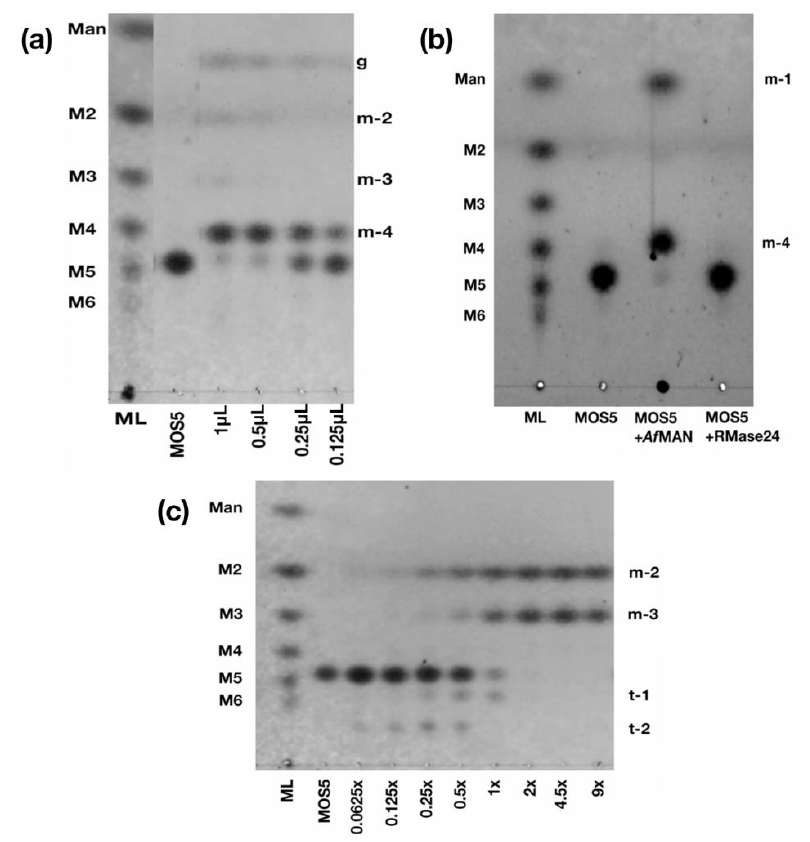
Figure 2. Enzymatic mapping of MOS5. ( a ) Digestion of MOS5 with C Af GLA. 1–0.125 µ L indicates Figure 2 . Enzymatic mapping of MOS5 . (a) Digestion of MOS5 with C Af GLA. 1 – 0.125 µL indicates a a reaction between 1 µ L of 1 µ M MOS5 and 1 µ L to 0.125 µ L of 20 mg / mL C Af GLA, respectively. reaction between 1 µL of 1 µM MOS5 and 1 µL to 0.125 µL of 20 mg/mL C Af GLA, respectively. (b) ( b ) Digestion of MOS5 with exo-beta-D-mannosidase ( A. fulica ) (Seikagaku corporation, Japan) and RMase24. ( c ) Digestion of MOS5 with various amount of p Af GLAF35. 0.0625–9.0000 × indicates a reaction between 1 µ L of 1 µ M MOS5 with 0.0625 µ L to 9 µ L of p Af GLAF35, amount ranging as labelled